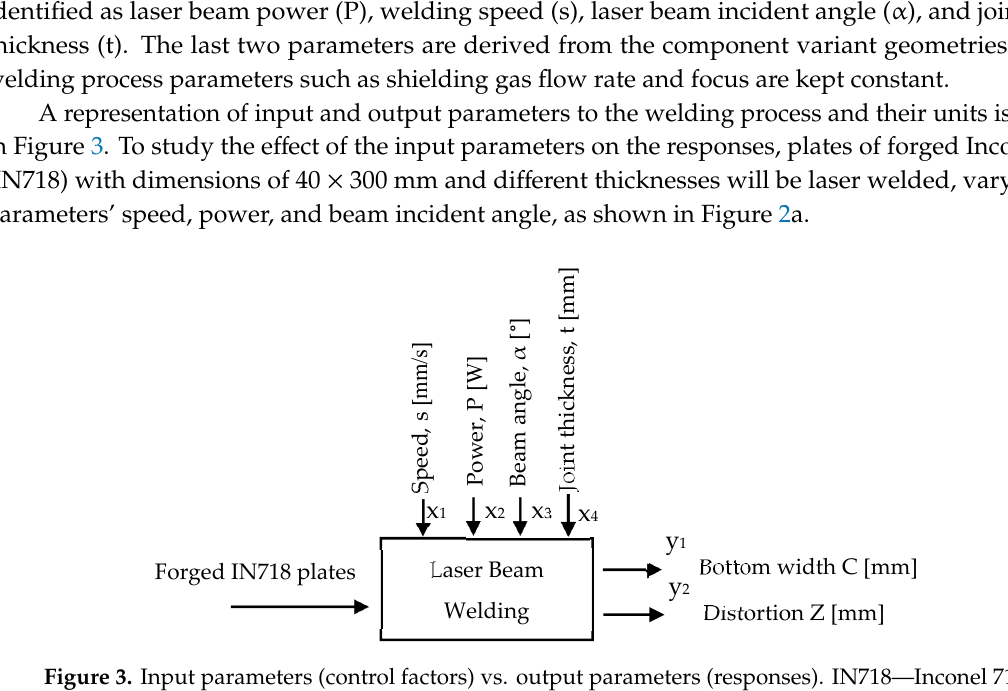
Figure 3. Input parameters (control factors) vs. output parameters (responses). IN718—Inconel 718.